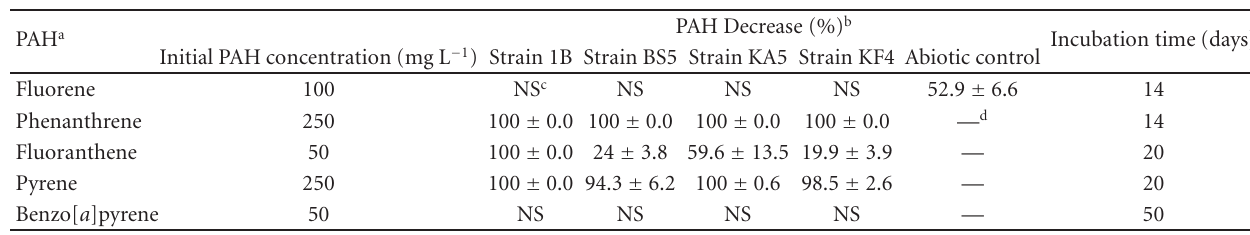
Table 5: PAH removal by Mycobacterium sp.